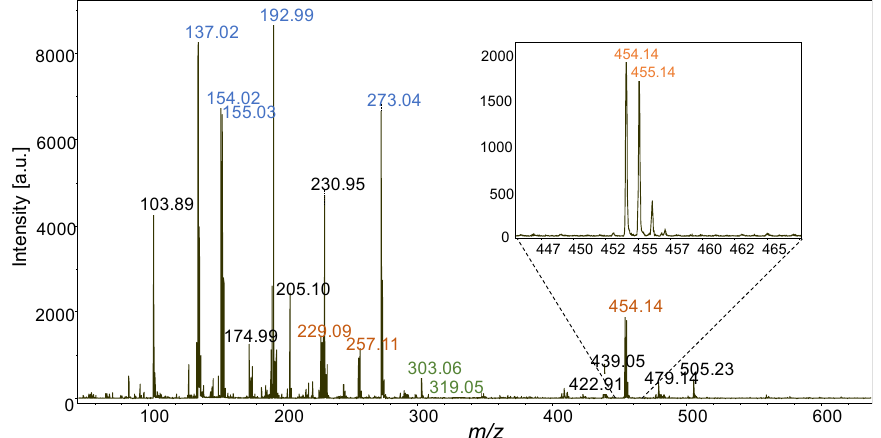
Figure 3. MALDI-TOF mass spectrum of stressed grapevine leaf: the blue peak labels correspond to matrix ions (DHB). Stilbene phytoalexins are detected as protonated and radical ions as it is observed for the viniferin in